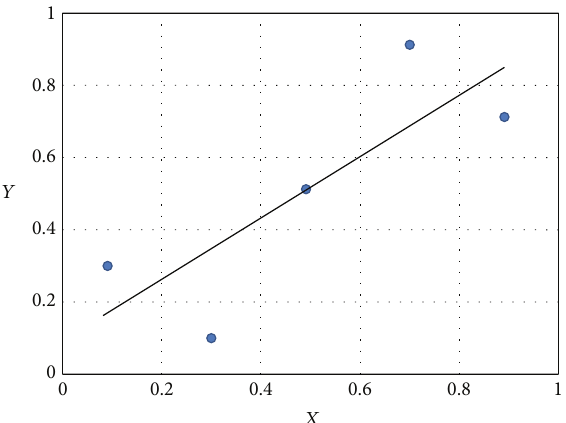
Figure 1: A scatter plot shows expression data of probe sets 𝑋 and 𝑌 for dataset [(0.1, 0.3), (0.3,0.1), (0.5, 0.5), (0.7,0.9), (0.9, 0.7)] .